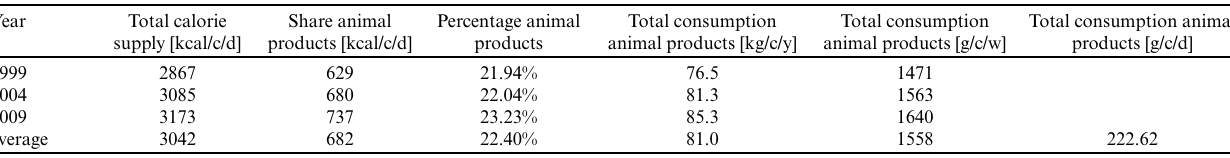
Table 2 . Food consumption of animal products in Brazil.